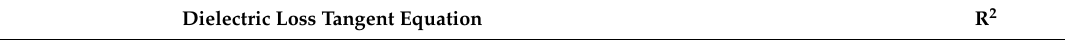
Table 3. Regression equations for the dielectric loss tangent (tan δ ) of the porous nHA/S composites at 1, 3, 5, 7, 9, and 11